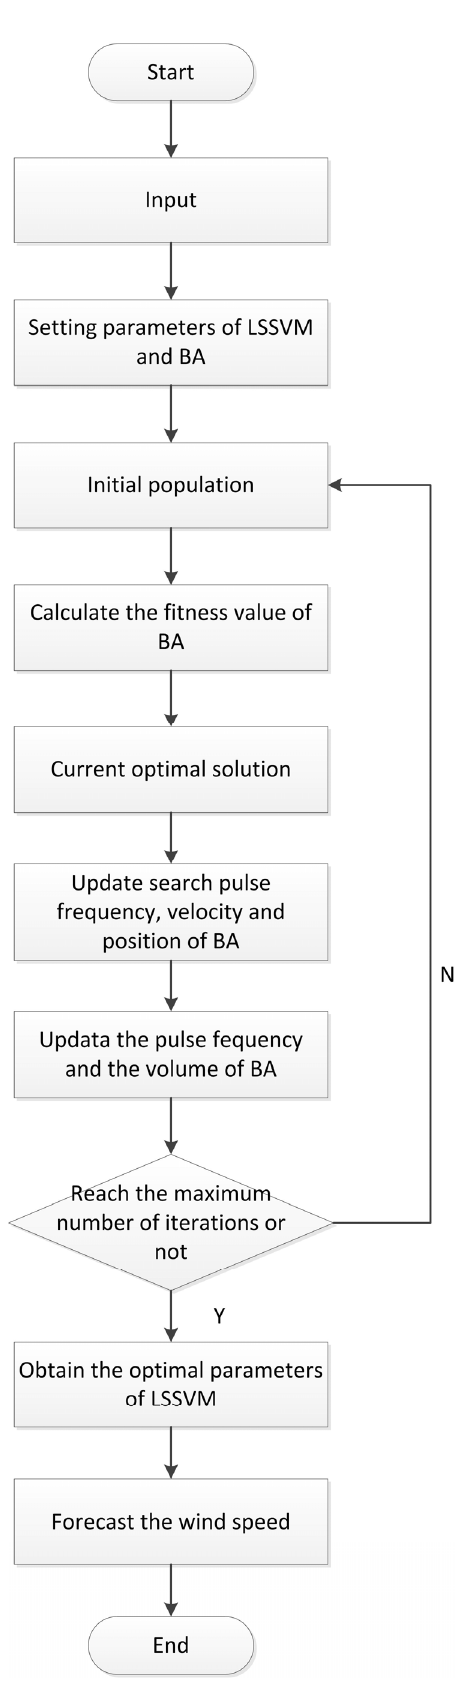
Figure 1. The flowchart of